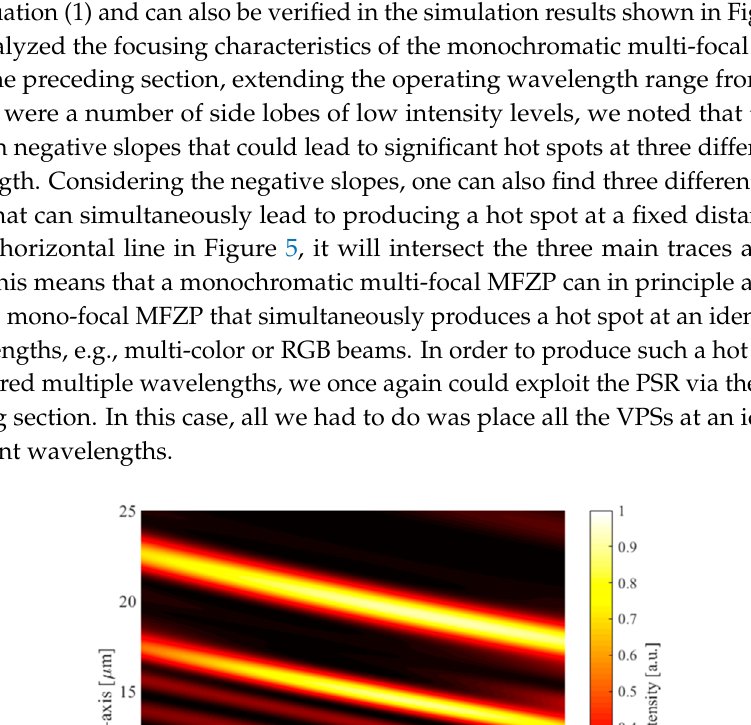
Table 2. Simulation parameters for a multi-chromatic, mono-focal MFZP.